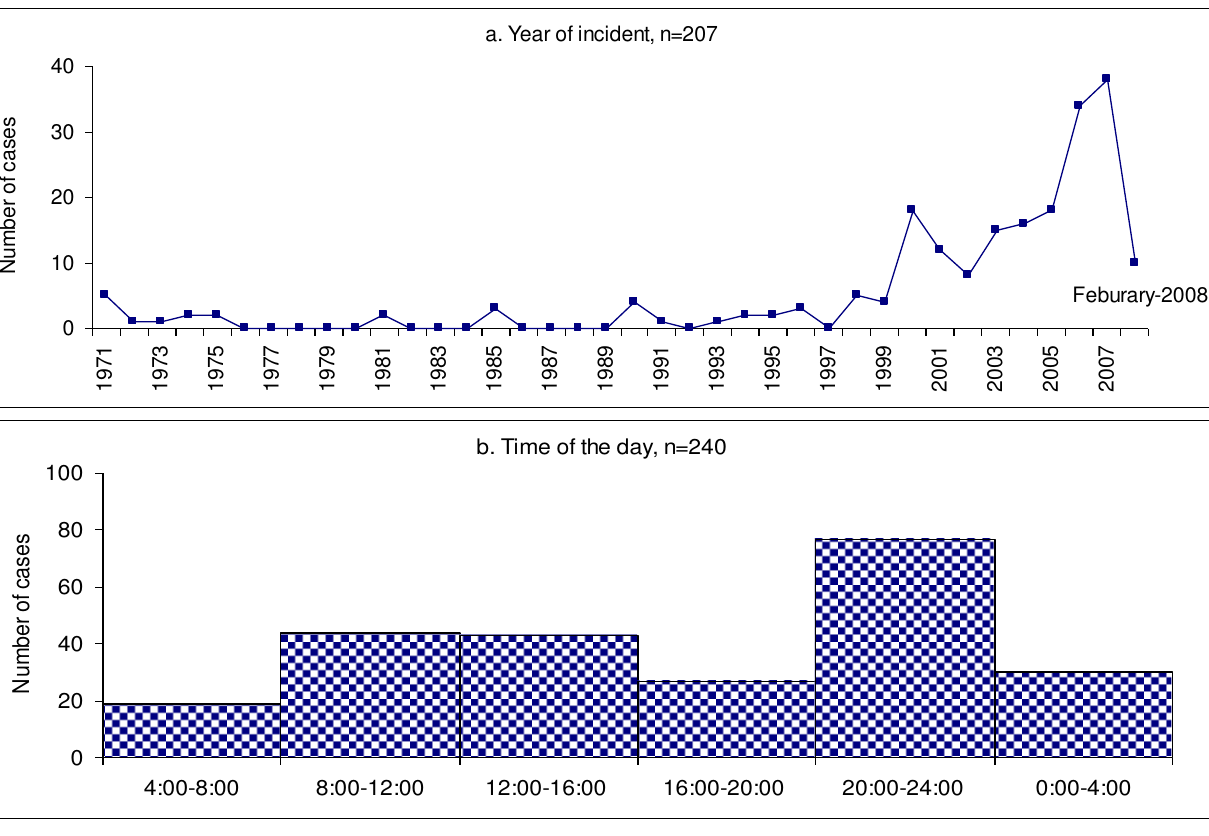
Figure 1 Trend and patterns of incident reporting